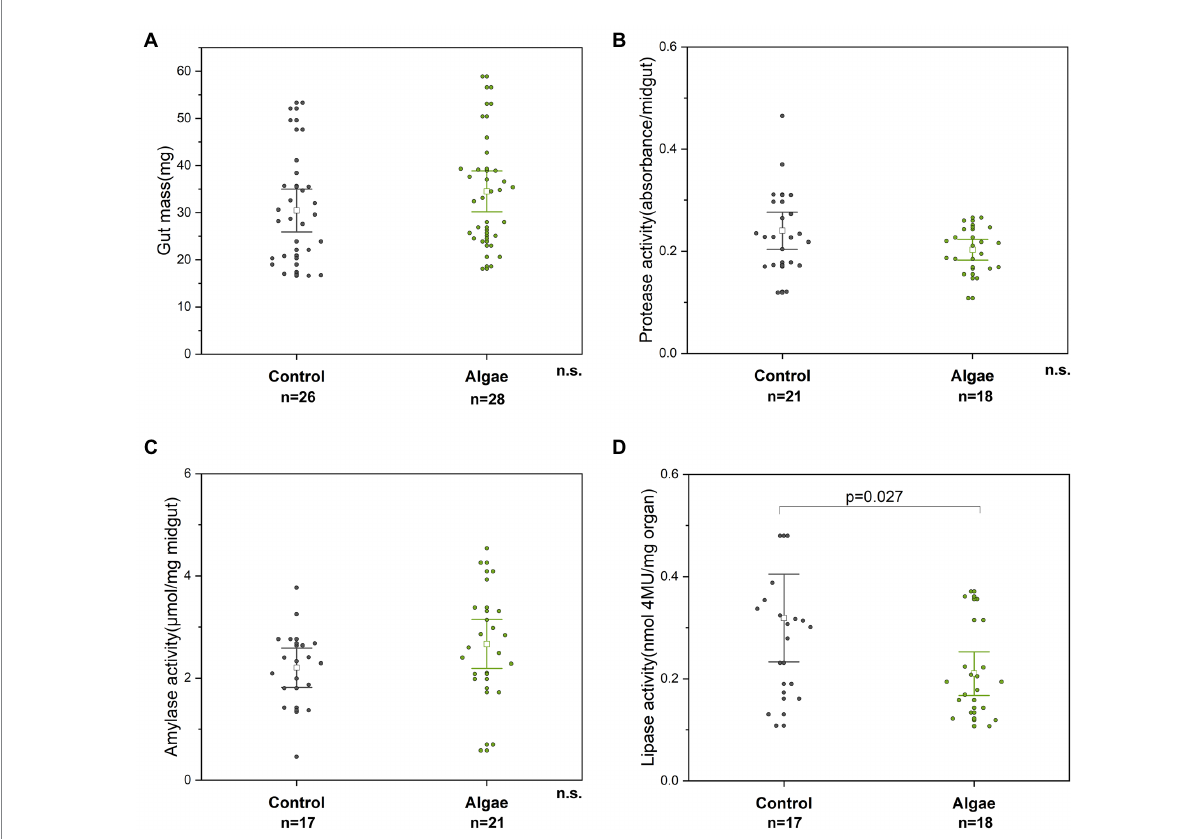
FIGURE 5 Parameters of the digestive system, specifically midgut mass (A) , the activities of protease (B) , amylase (C) , and lipase (D) . n. s. – non-significant difference. Control – bees from colonies fed with APIVITAL® sugar syrup. Algae – bees from colonies fed with 10% (w/v) Chlorella powder in APIVITAL® sugar